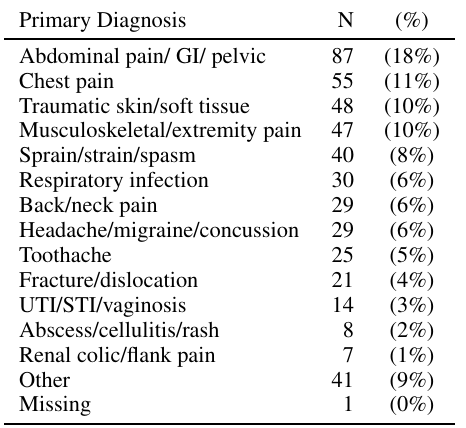
Table 1. Primary Diagnosis Among 482 Study Participants